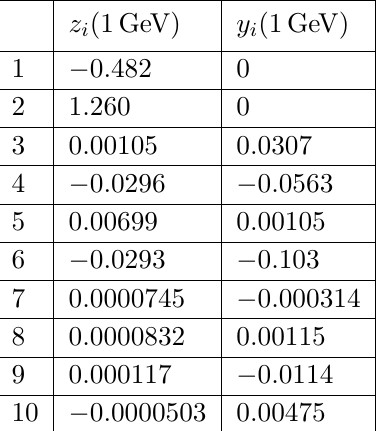
Table 1 . ∆ S = 1 Wilson Coefficients at NLO in the MS (NDR) scheme at µ = 1 GeV.